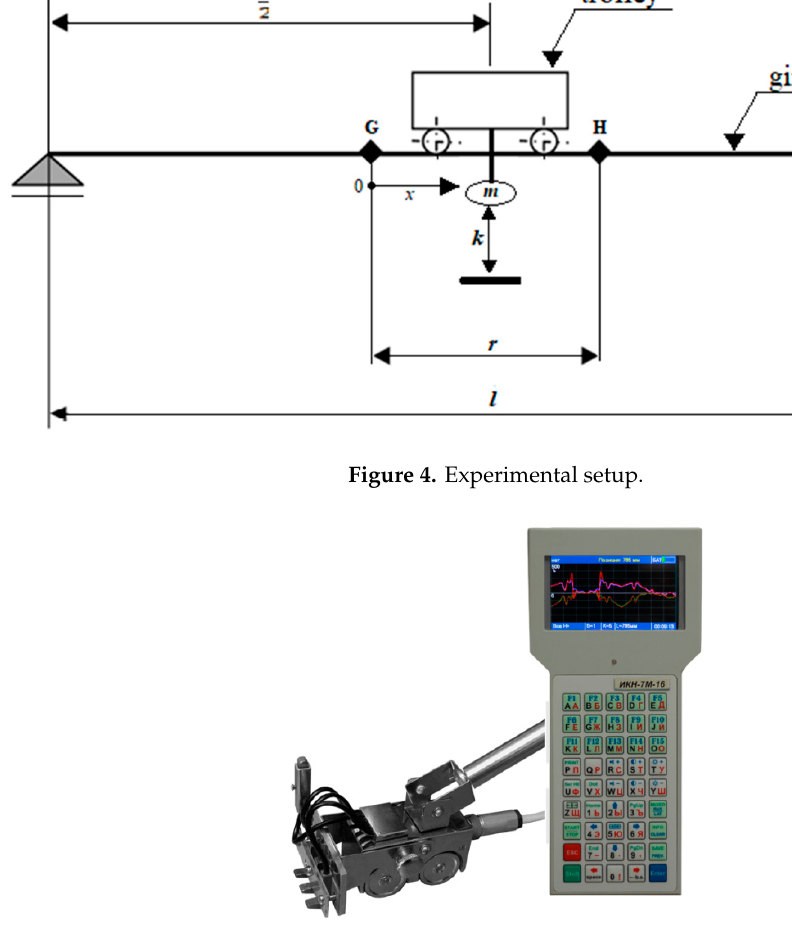
Figure 5. Tester of Stress Concentration TSC-4M-16 and scanning 4-channel sensor.